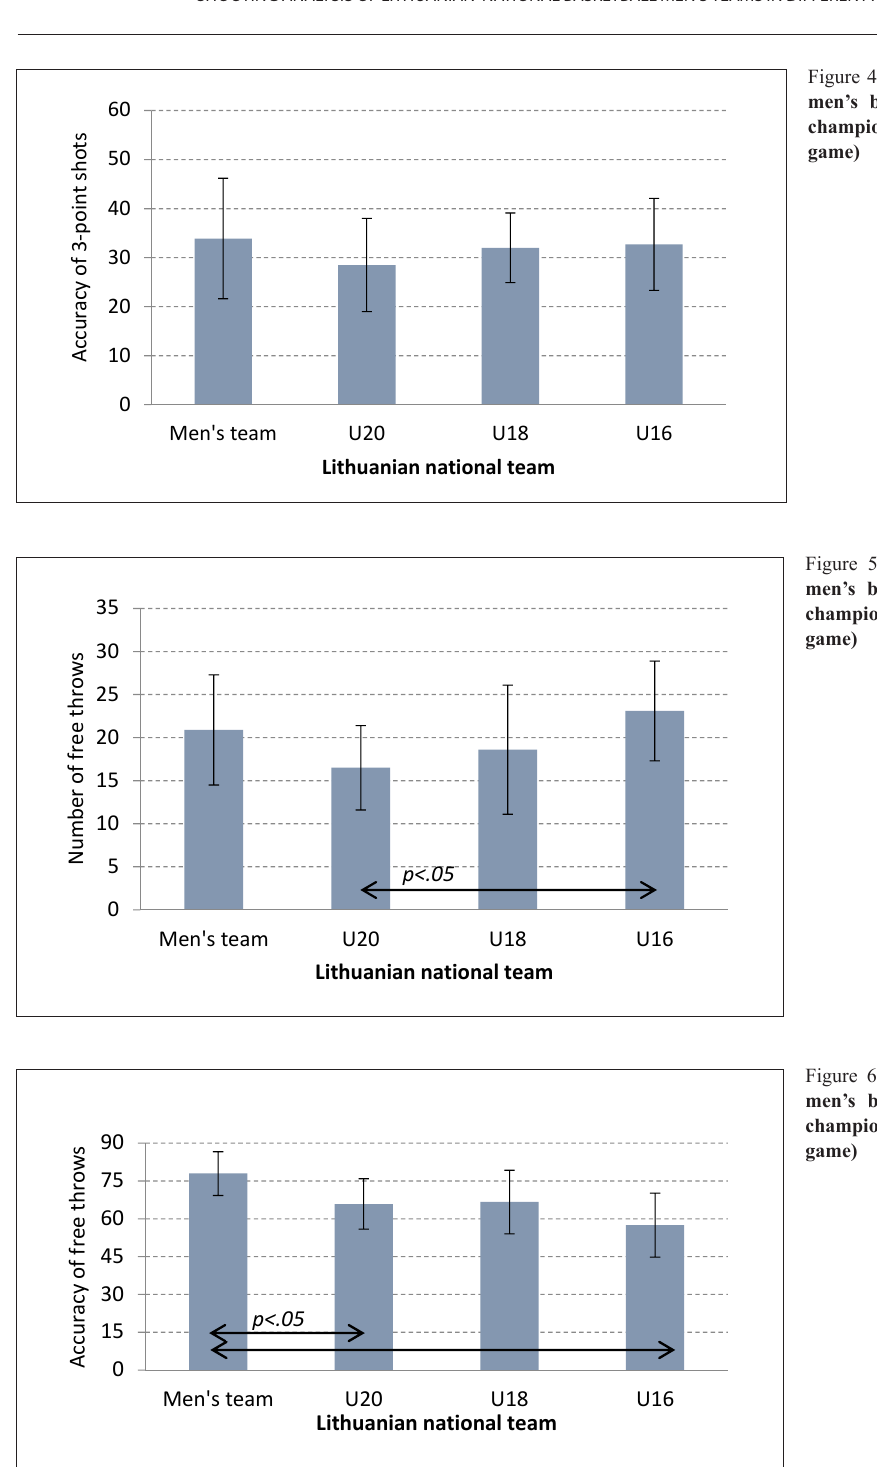
Figure 6. The accuracy of free throws for men’s basketball teams in the European championship matches (average per one game)